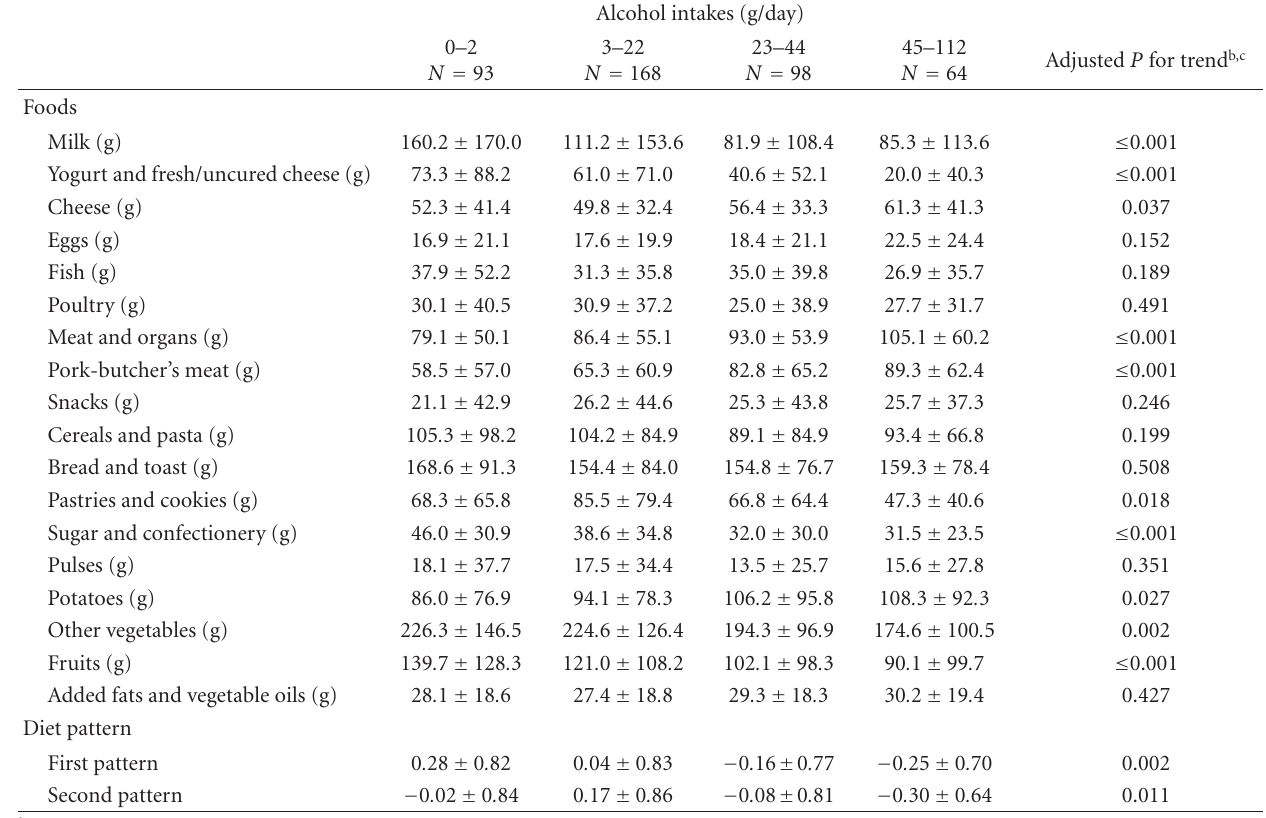
Table 3: Daily intake of foods and nutrients according to alcohol consumption in the sample of 423 adult males a